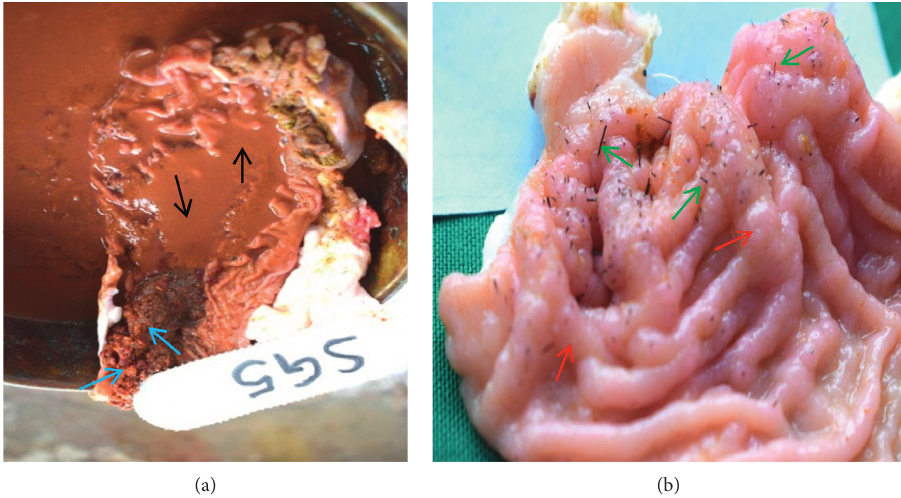
Figure 8: (a) Abomasitis showing dark-tan-coloured abomasal contents at the fundus and corpus regions of abomasum (black arrows) and seeds of Opuntia stricta fruits packed at the pyloric region (blue arrows). (b) Another case of abomasitis showing thorns and spines embedded into the mucosa (green arrows) and thickened abomasal folds (red arrows) of goats that had consumed Opuntia stricta .